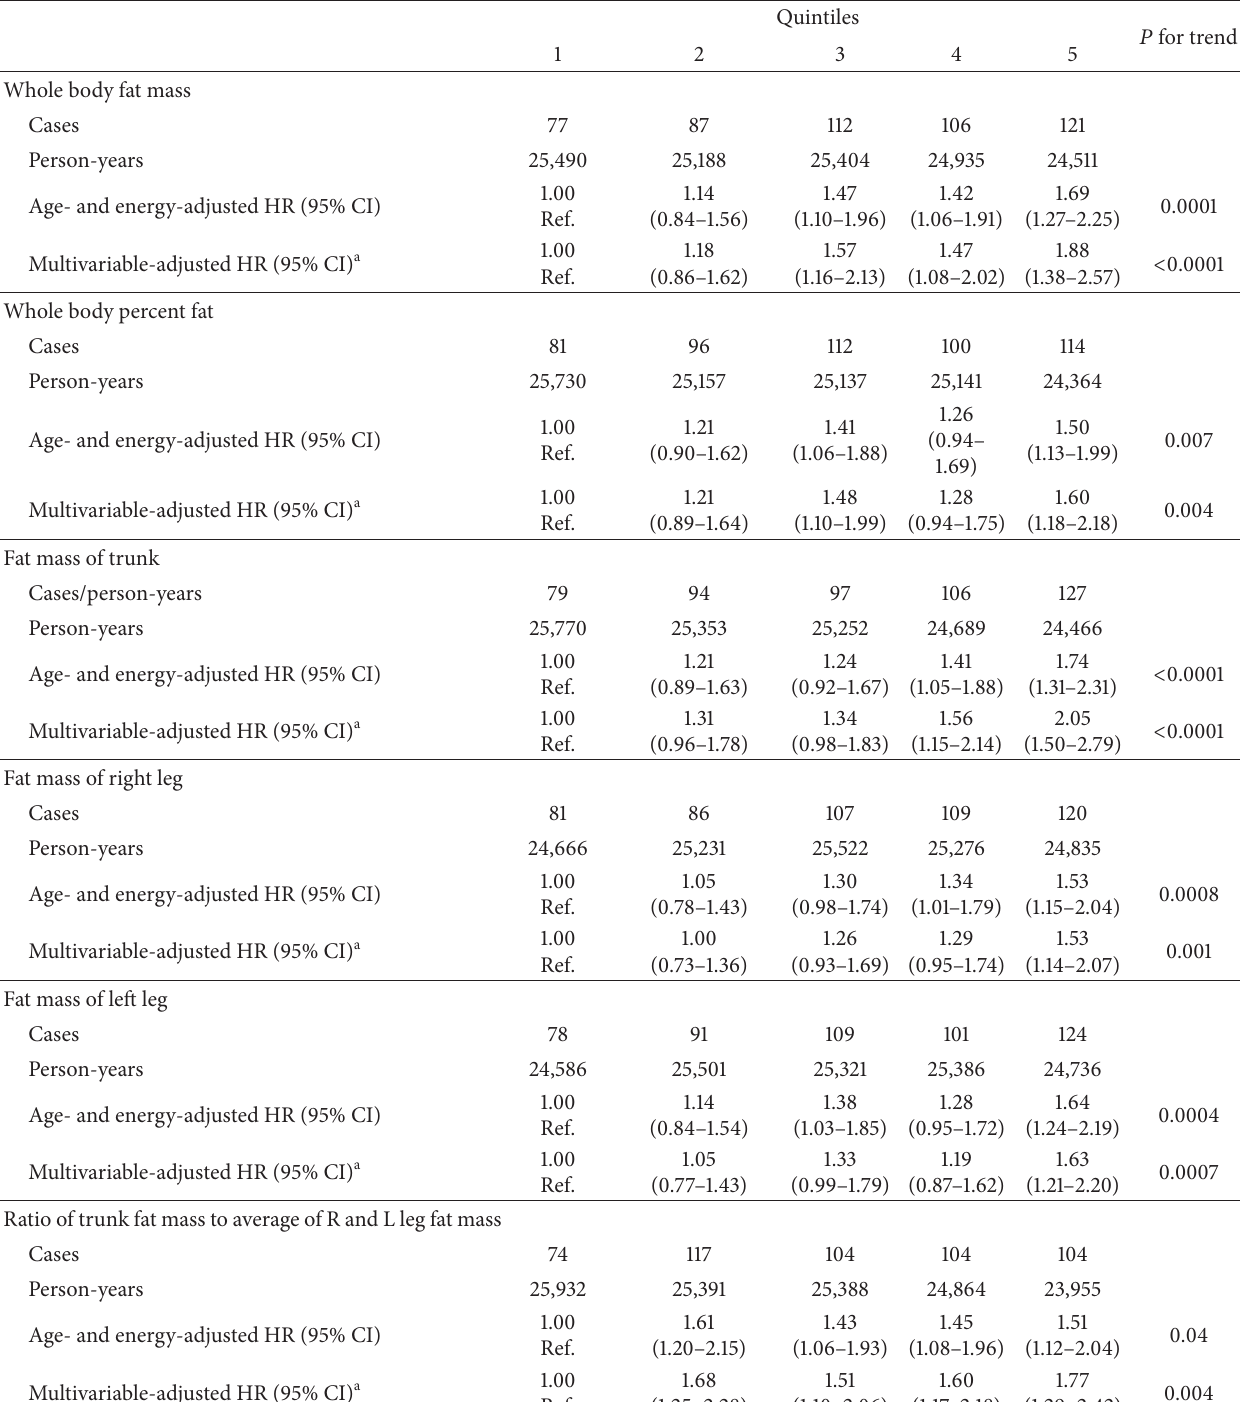
Table 3: Hazard ratios (HR) and 95% confidence intervals (CI) for the association of DXA-derived body fat measured at baseline with risk of incident, invasive breast cancer in postmenopausal